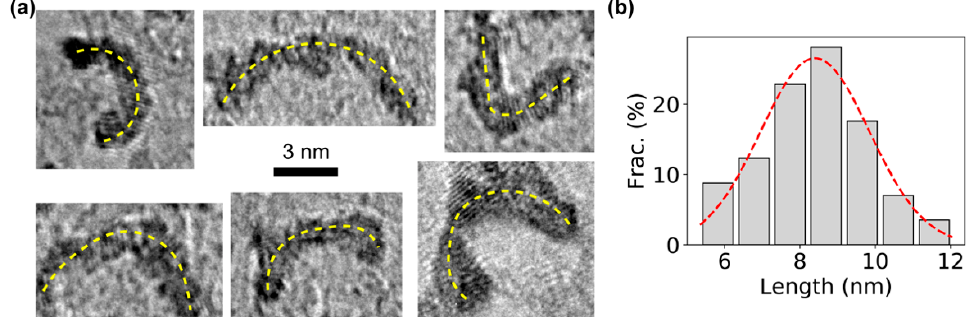
Figure 2. TEM visualization of bent DNA bows. ( a ) Examples of TEM images of DNA bows. The bending of the DNA bows is highlighted by the yellow dashed lines. Scale bar = 3 nm. ( b ) Distribution of the arc lengths of DNA bows, which was fitted by a Gaussian distribution (red dashed line), resulting in an average length of 8.4 ± 1.4 nm (mean ± standard deviation).